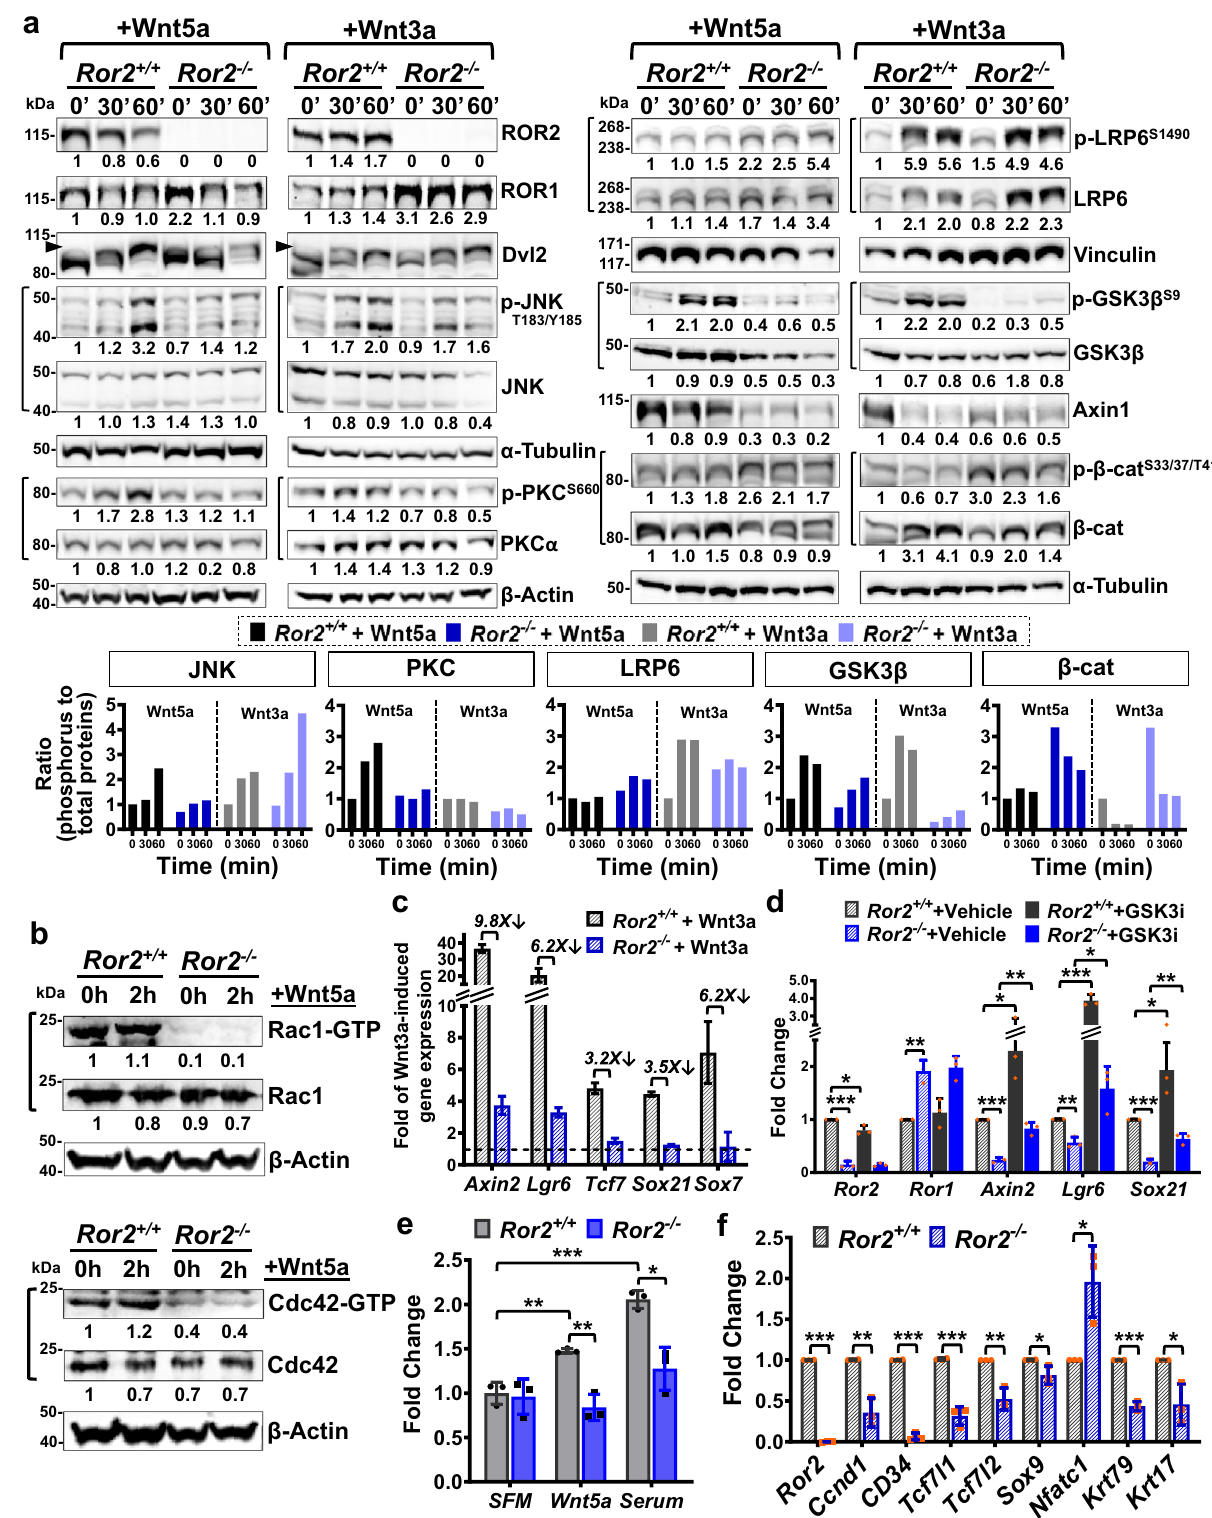
for DNA double-strand breaks (DSBs) 71 , and 8-oxoguanine (8-oxoG), a biomarker for measuring the effect of oxidative DNA damage 72 . As shownin Fig. 5c and Supplementary Fig.5a, three times moreof Ror2 − / − HFSCs showing over 6 γ H2AX foci than Ror2 +/+ HFSCs indicated the accumulation of DNA DSBs in Ror2 − / − HFSCs. We also found a sig- ni fi cant percentage of Ror2 − / − HFSCs displaying nuclear staining of 8- oxoG, something not detected in the nuclei of Ror2 +/+ HFSCs (Fig. 5d).